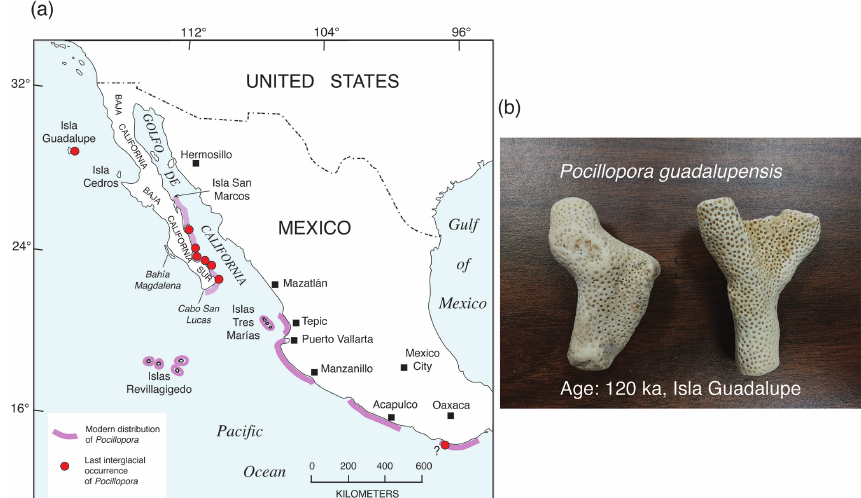
Figure 42. (a) Map showing the modern distribution of species of the hermatypic coral genus Pocillopora (purple shading; from Reyes- Bonilla and López-Pérez, 1998) and U-series-dated MIS 5e occurrences of this genus elsewhere in the region. MIS 5e age and faunal data from Durham (1980), Lindberg et al. (1980), Sirkin et al. (1990), Szabo et al. (1990), Muhs et al. (2002a), DeDiego-Forbis et al. (2004), Johnson et al. (2007), and Tierney and Johnson (2012). Occurrence of fossil Pocillopora on the Mexican coast south of Oaxaca is undated but could be of MIS 5e age and is from Palmer (1928a, b). (b) Photograph of fragments of Pocillopora guadalupensis from Isla Guadalupe, Mexico, dated to ∼ 120ka (Muhs et al., 2002a). Photograph by Daniel R. Muhs.